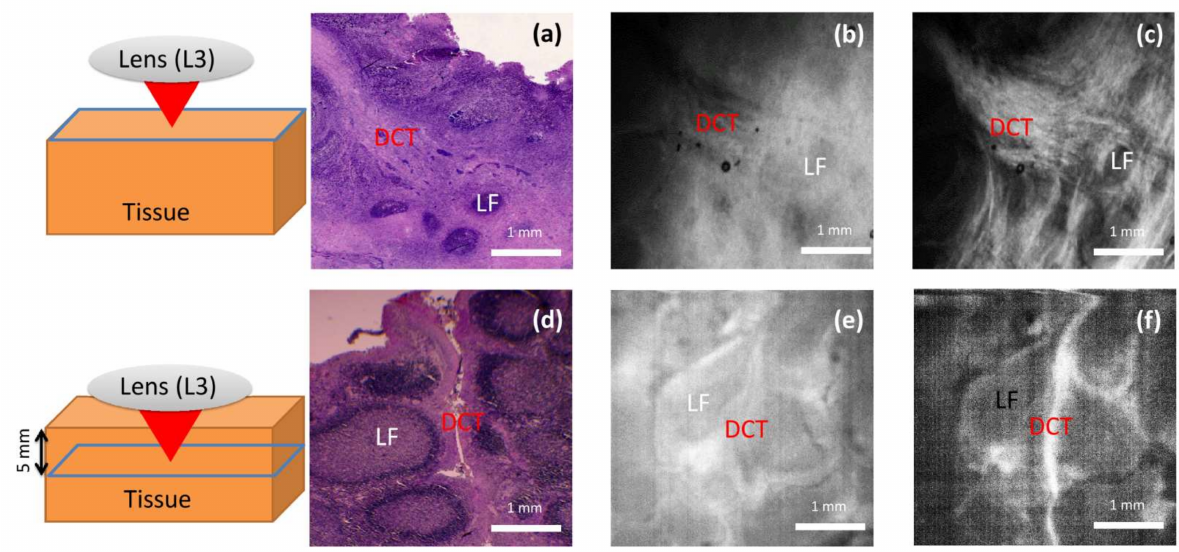
Figure 3. En face images of the tonsil acquired near the top surface of the tonsil are shown in the top row and the images acquired 5 mm below the top surface are shown in the bottom row. H&E stained image of the tonsil ( a , d ), co-polarized image of the tonsil ( b , e ), and cross-polarized image of the tonsil ( c , f ). Different features such as the dense connective tissue (DCT) and lymphoid follicles (LF) can be